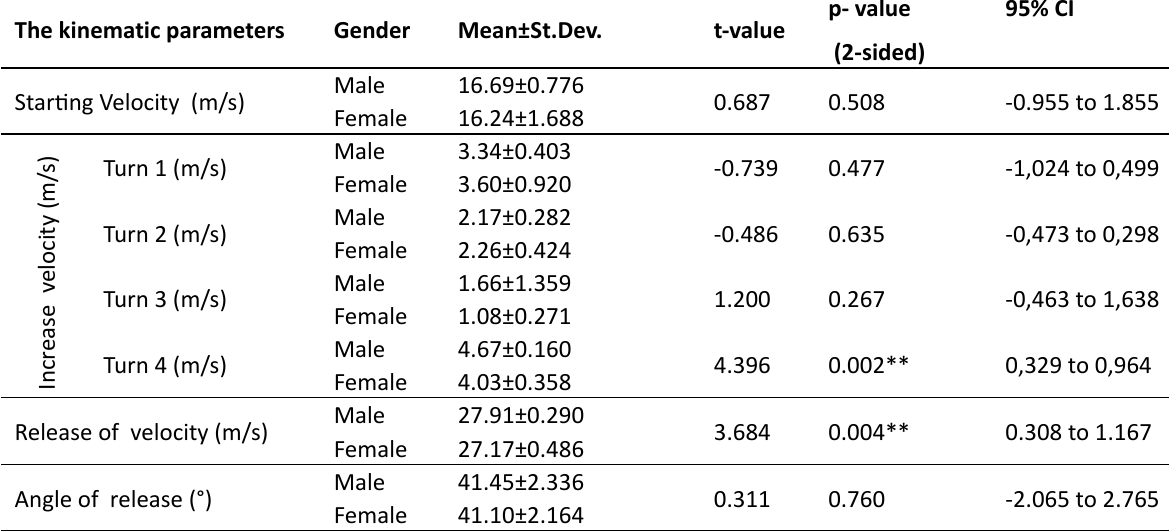
Table 2. The differences in kinematic parameters between male and female Hammer throwers The kinematic parameters Gender Mean±St.Dev.